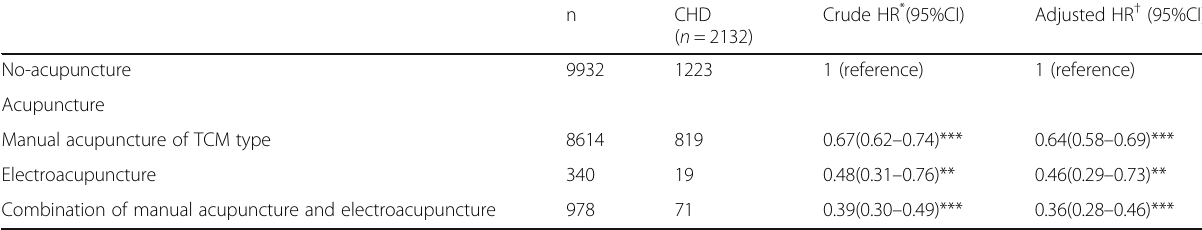
Table 4 Cox model for coronary heart disease in patients with rheumatoid arthritis receiving different types of acupuncture treatment vs. not receiving acupuncture